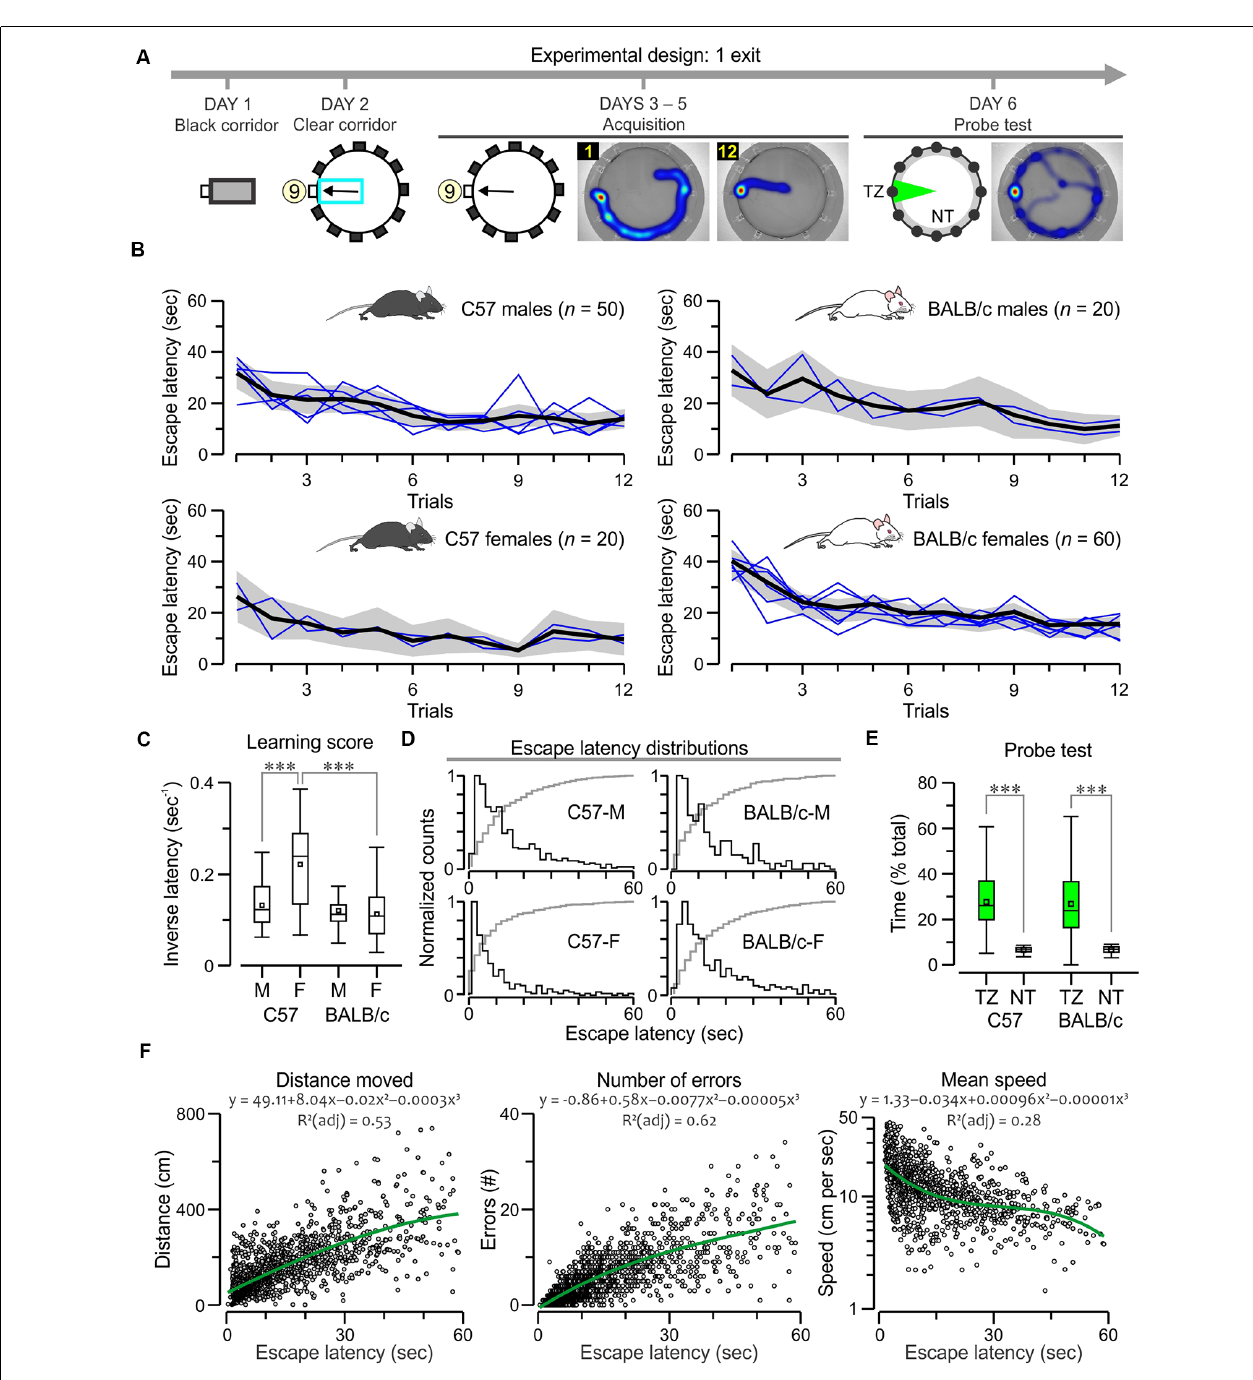
FIGURE 2 | C57 and BALB/c mice show comparable acquisition of the 1-exit test. (A) Experimental design of the task, showing plan views of the apparatus with hole 9 as the true exit and heatmaps for a subject on trials 1, 12 and the probe test. Abbreviations: TZ, target zone; NT, non-target zones. (B) Plots of escape latency across trials for C57 and BALB/c groups. The black lines denote the ensemble means for the time series, the gray areas are the 5%–95% range, and the blue lines are means for the each separately tested cohort ( n = 10). Both strains learn the task comparably; F > 3, P < 0.0001, repeated measures analysis of variance (RMANOVA; exact values in “ Results ” section). (C) Boxplot of learning scores (i.e., inversed latencies, which are calculated by taking the values for all trials for each animal) showing that C57 females have the highest scores ( ∗∗∗ P < 0.0001, t -test) and the other groups have similar scores. (D) Histograms of escape latencies (black lines) for successful trials that lasted less than 60 s. The gray lines are cumulative probabilities. (E) Boxplot of search time in the TZ (% of total time, 60 s) and the NT (expressed as the average of the 11 decoys) for BALB/c ( n = 30) and C57 ( n = 20) groups, both of which show significantly higher TZ exploration ( ∗∗∗ P < 0.0001, t -test). (F) Scatterplots showing a correlation of escape latency ( n = 1,597 trials that lasted less than 60 s) with distance moved, number of errors and mean speed (plotted in log scale). Green lines represent polynomial fits for the datasets, which are described by the corresponding functions.